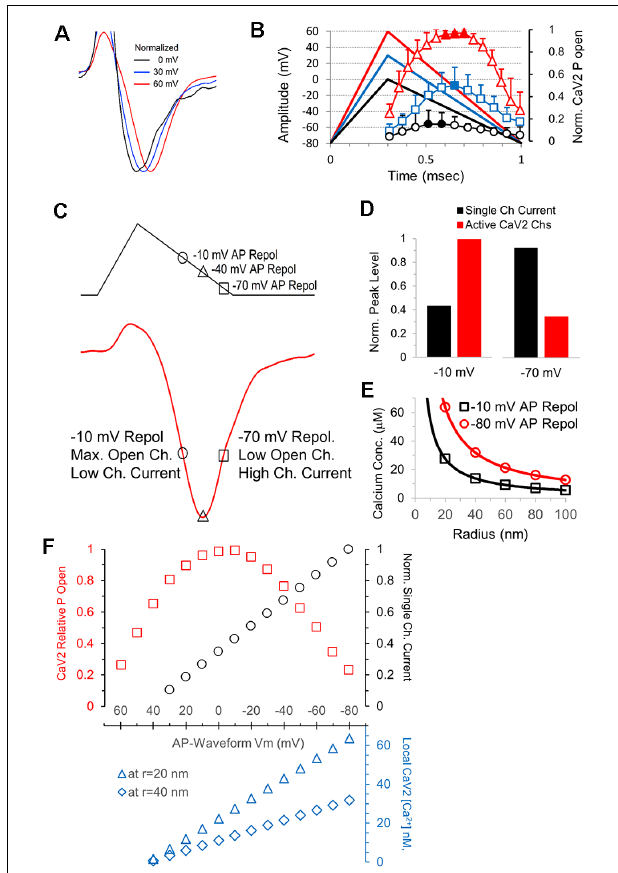
FIGURE 8 | The electrical driving for calcium, not the number activated channels, determines the shape of the calcium channel response. (A) Responses shown in Figure 7 were normalized in amplitude to show how the time to reach peak amplitude increases as the amplitude of the stimulus voltage increases (60 mV, red; 30 mV, blue; and 0 mV, black. (B) Overlay of the AP-like stimuli and the CaV2 open probability data from Figure 7C shows the relationship between the stimulus time and the amount of CaV2 activation. (C) The AP-like stimulation and corresponding CaV2 current to show the relationship between the repolarization voltage at − 10, − 40 and − 70 mV and the calcium current. The current at − 10 and − 70 mV are similar in this example, but the number of open calcium channels and the single-channel current differ greatly. (D) Graphs of the relative single-channel current (black) and CaV2 open probability (red) at repolarization values of − 10 and − 70 mV. The increased single-channel conductance at − 70 mV offsets the reduction in the number of active calcium channels. (E) The single-channel current at when the AP repolarization is at − 10 mV (black) and − 80 mV (red) was used to calculate the local calcium concentration at individual CaV2 channels, at distances of 20–100 nm (radius). Channels that are still active at − 80 mV have > 2-fold higher local calcium concentrations than the channels that are active at − 10 mV. (F) Graph of the relative CaV2 open probability, single-channel current, and local calcium concentrations during the AP-like repolarization from 60 to − 80 mV. Local CaV2 calcium concentrations at the different membrane potentials are shown for a distance of 20 nm (blue triangles) and 40 nm (blue